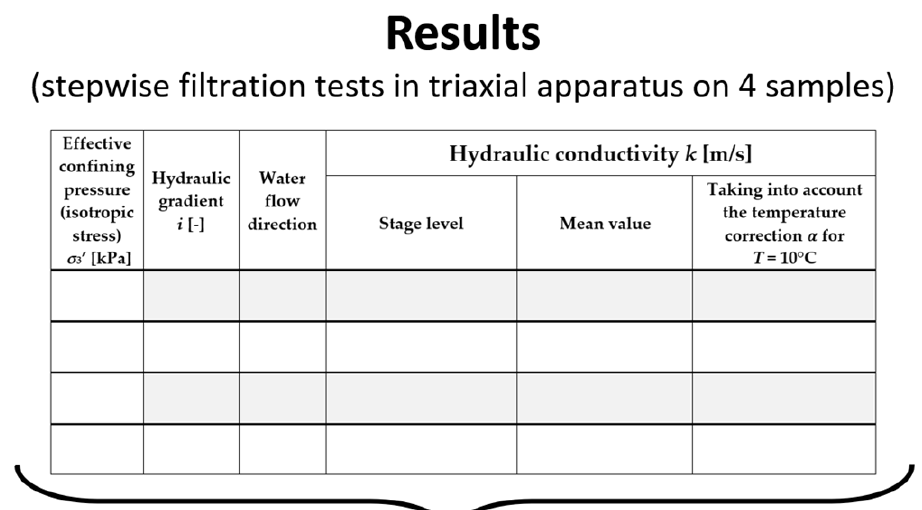
Figure 6. Grain size distribution curves of mineral residues from burning peat samples.